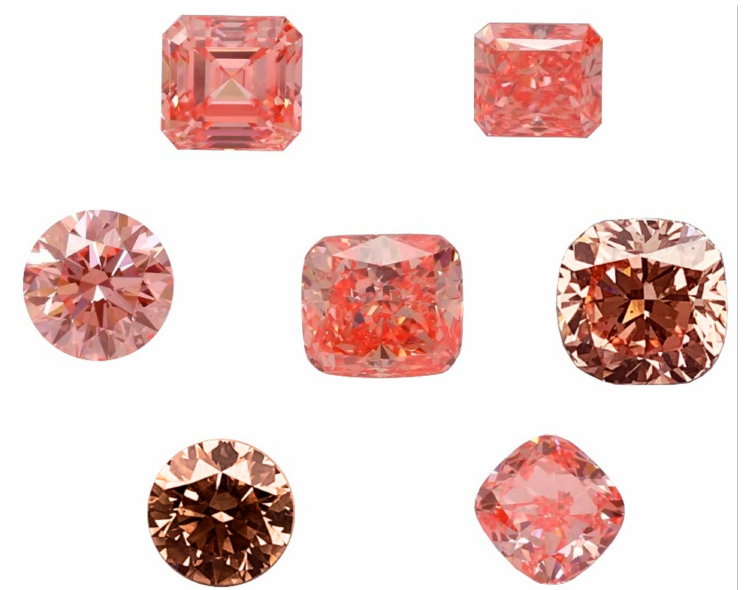
Figure 1. The pink or pinkish type Ib CVD synthetic diamonds examined for this study were treated by irradiation and annealing. The sample numbers are ZX11, 09, 13, 12, 04, 03, 10, respectively, from left to right and top to bottom. Photos by Z. Song.